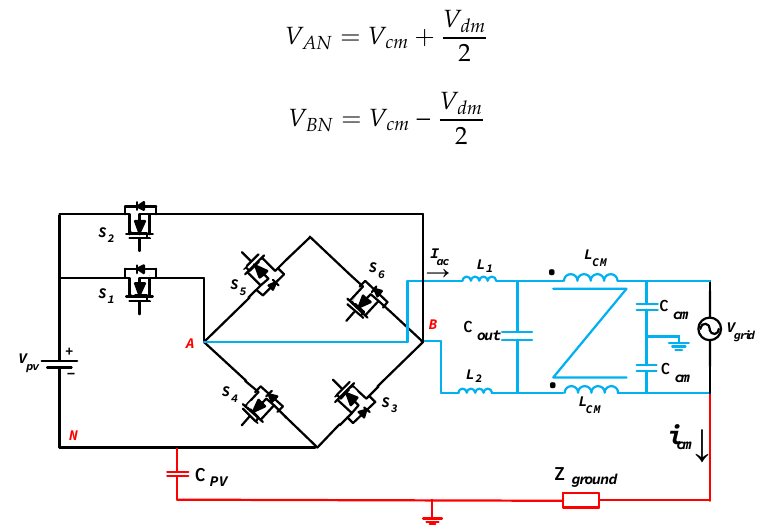
Figure 6. Proposed inverter structure with a common mode path.